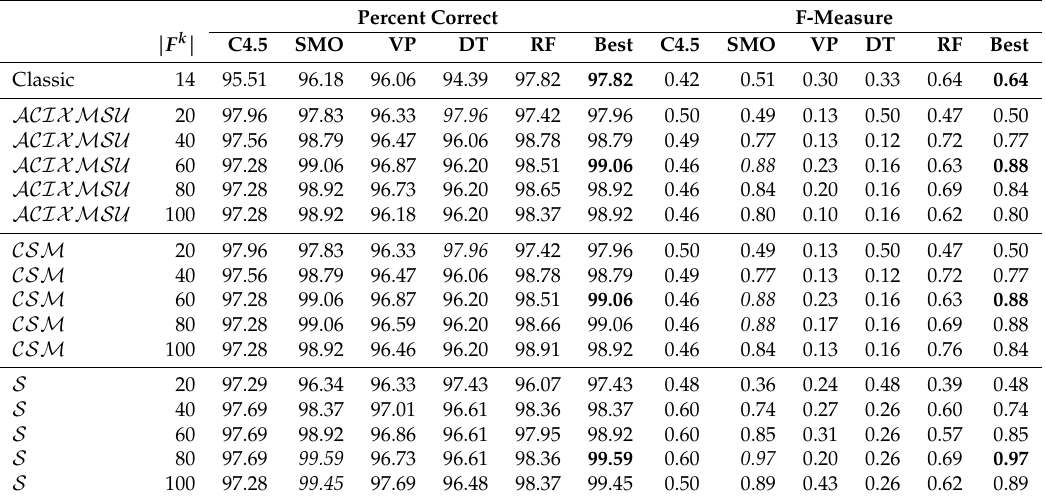
Table 8. “Prepare dinner” classification performance.